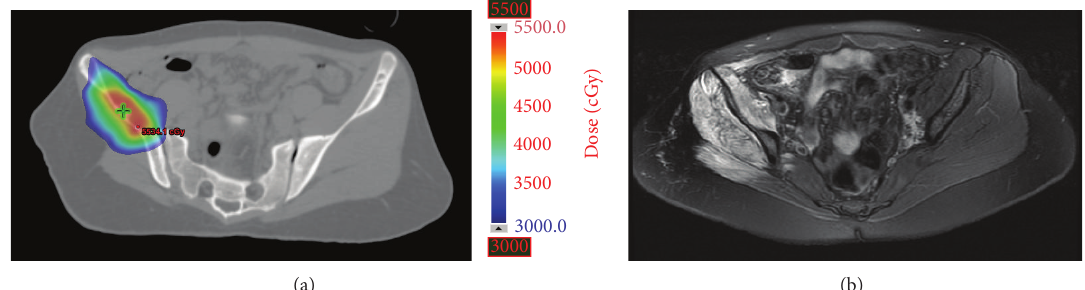
Figure 3: Representative axial dose color wash (a) for a 17-year-old female treated with 50 Gy in 5 fractions for oligometastatic osteosarcoma of the iliac wing and (b) axial magnetic resonance imaging two months after treatment, demonstrating myonecrosis, with correlation between treatment volumes and subsequent soft tissue changes.